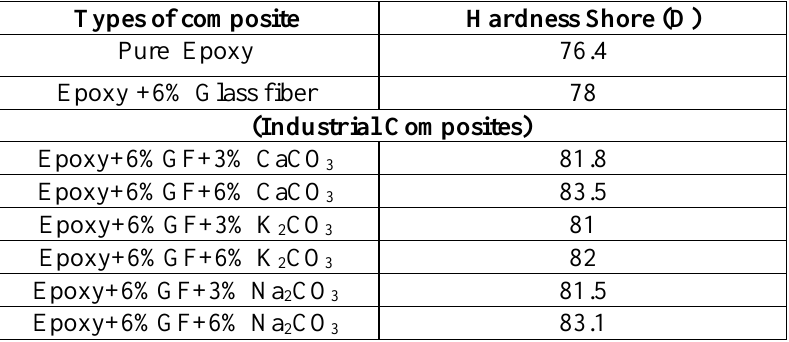
Table 4: Hardness of the prepared